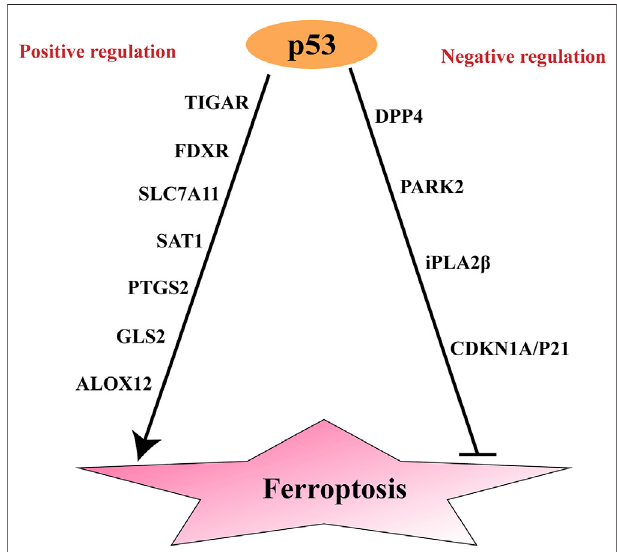
FIGURE2| Positive andnegative regulationofp53toferroptosis. SAT1, Spermidine/spermine N1-acetyltransferase; ; ALOX15, Arachidonic acid 15 lipoxygenases; GLS2, Glutaminases; PTGS2, Prostaglandin-endoperoxide synthase 2; ALOX12, Arachidonic acid 12 lipoxygenases; TIGAR, TP53- induced glycolysis and apoptosis regulator; FDXR, Ferredoxin reductase; DPP4, dipeptidyl peptidase-4; CDKN1A, encoding p21: cyclin-dependent kinase inhibitor; PARK2, parkinson disease